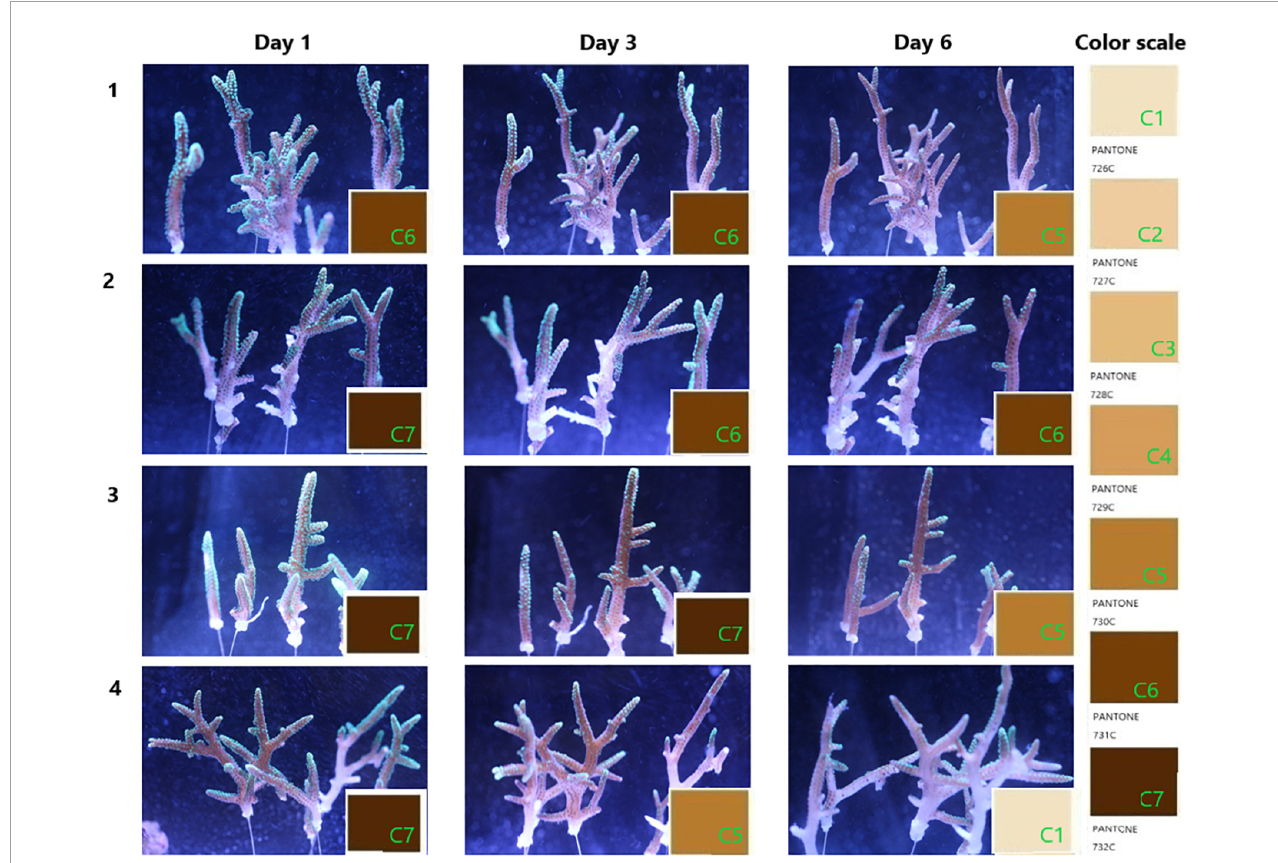
FIGURE2 Progress of coral bleaching. The coral branches were cultured in pump recycling water with a salinity of 33.3